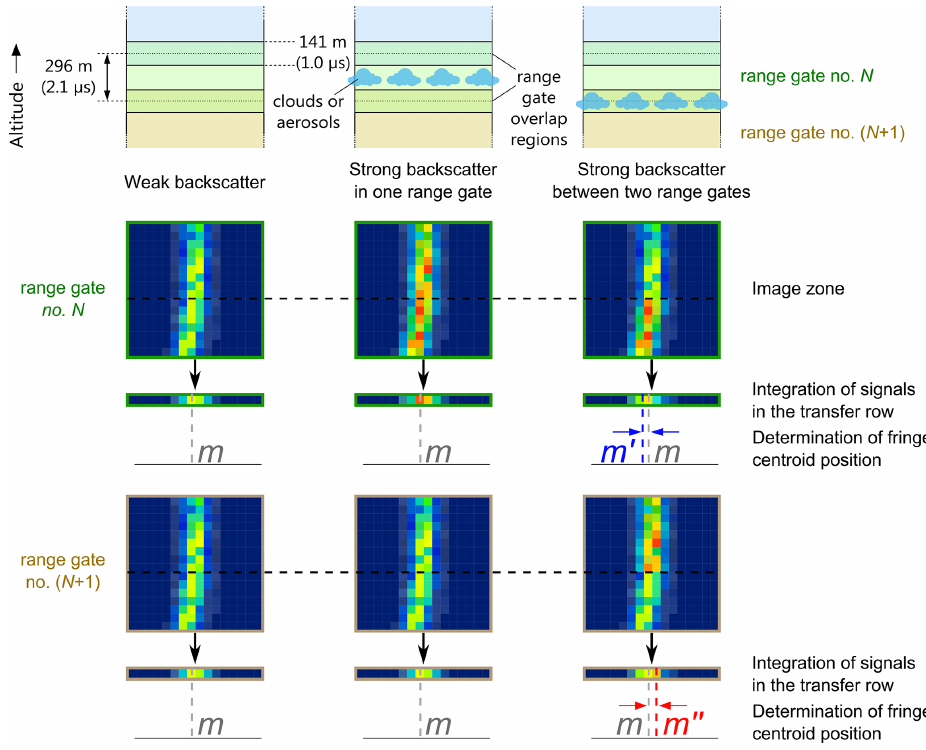
Figure 9. Illustration of Mie wind errors due to fringe skewness (see the text for an